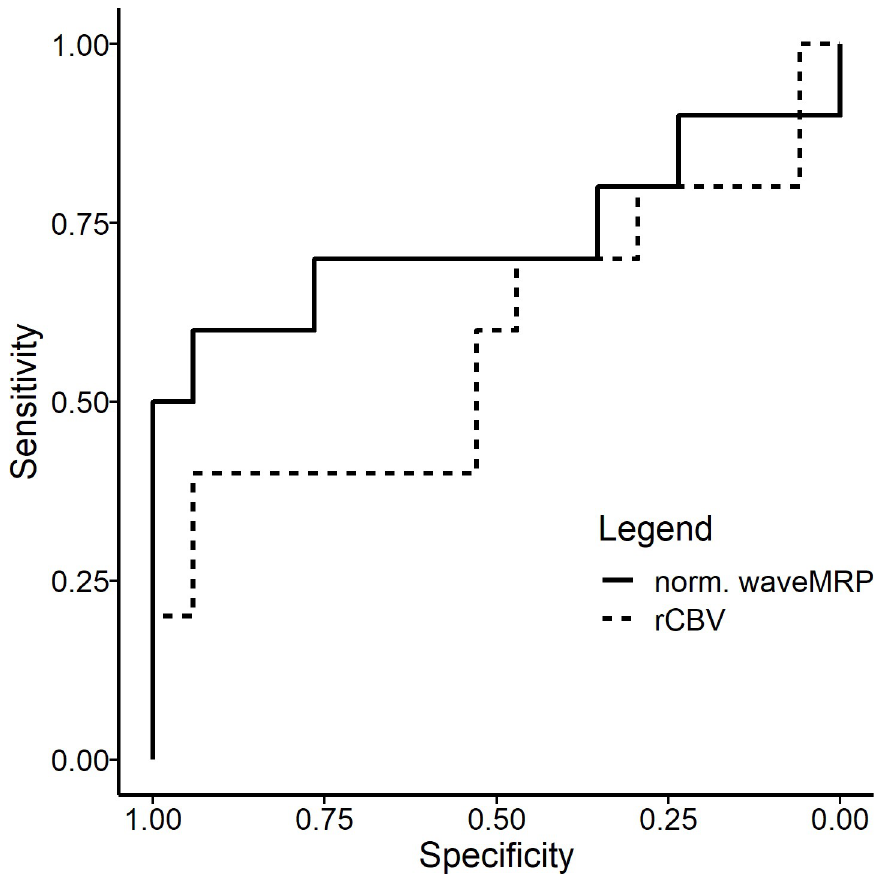
Fig 6. Receiver Operating Characteristic (ROC) curve for dichotomized CD31 expression and normalized CBV and normalized wavelet-MRP.